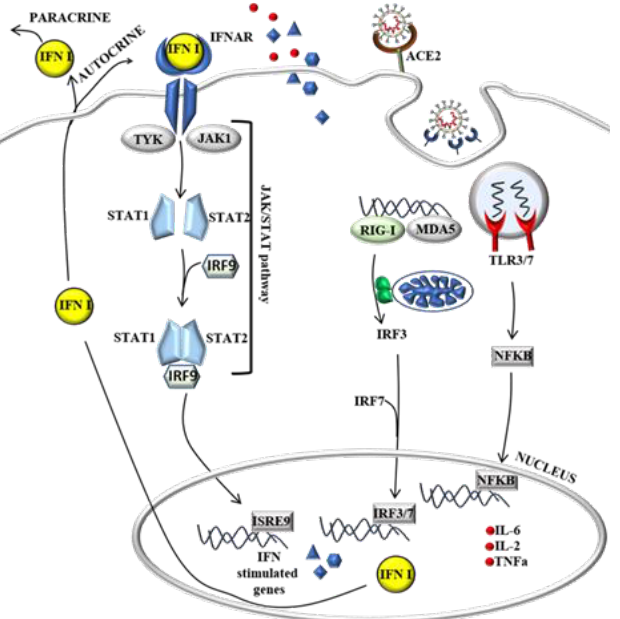
Figure 4. Immune response activation due to SARS-CoV-2 infection. The presence of virus particles in the cell, such as the viral RNA, is recognized by the Toll-Like and RIG-I/MAD5 pathway and will initiate signaling cascades resulting in the translocation of NF-kb and IRF3/7 into the nucleus and the transcription of pro-inflammatory cytokines that are responsible for recruiting immune cells to the site of infection (left).